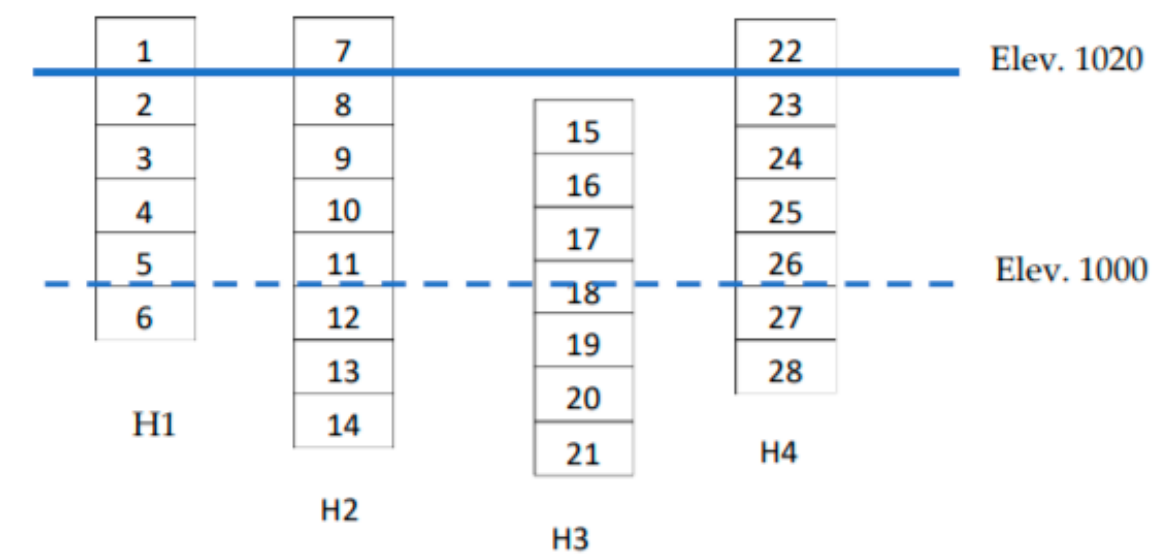
Figure 2. Cross section view of the example holes (four) containing a total of 28 lithological segments. Two lines show elevations (“Elev.”) of 1020 and 1000.